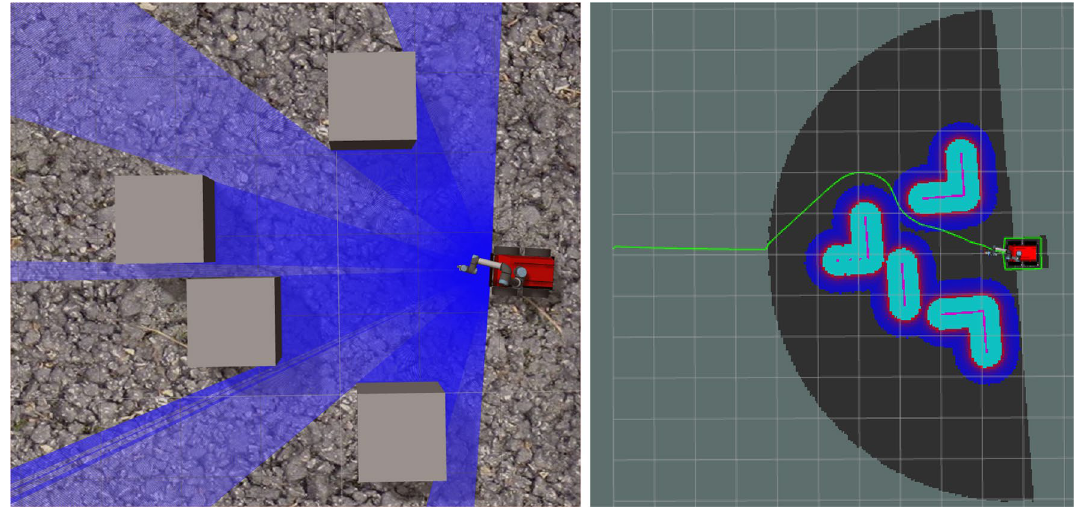
ment and the occupation probability of the cells are used by the planner to compute the path of the